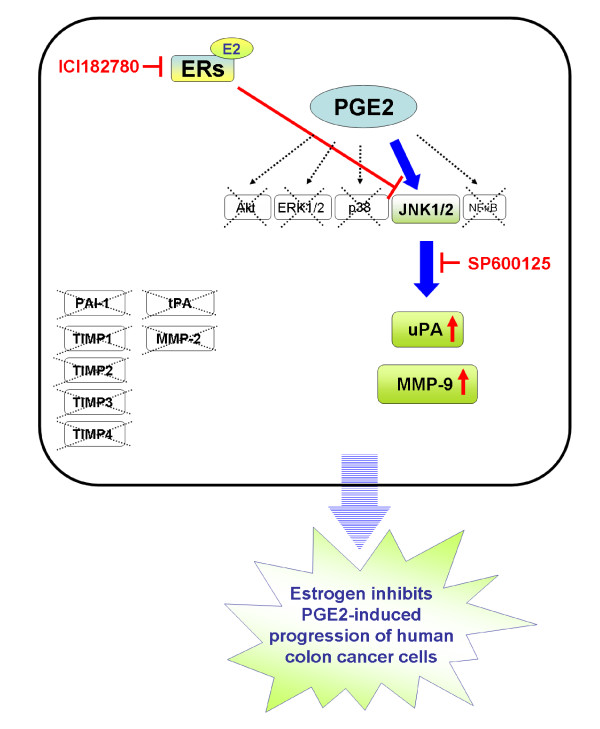
A schematic representation showing 17β-estradiol inhibition of uPA and MMP-9 expression, and cell motility via suppression of JNK1/2 pathway in human LoVo colon cancer cells. Administration of prostaglandin E2 (PGE2) rapidly activates kinase such as JNK1/2, thus leading to the expression of downstream targets including uPA and MMP-9, which further promotes cellular motility in human LoVo cancer cells. However, PGE2 treatment shows no effects on regulation of tPA, MMP-2, PAI-1 and TIMPs (TIMP-1, TIMP-2, TIMP-3 and TIMP-4). Estrogen receptor is activated by 17β-estradiol binding to form 17β-estradiol-ER complex. 17β-Estradiol-ER complex presents the properties of anti-cancer by downregulating expression of uPA amd MMP-9 via deactivation of JNK1/2 in LoVo cells. It suggests that 17β-estradiol might inhibit PGE2-induced motility of human LoVo colon cancer cells.